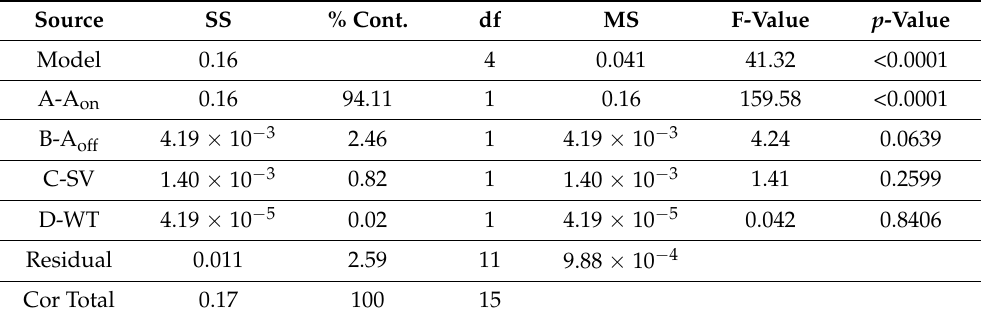
Table 6. ANOVA for